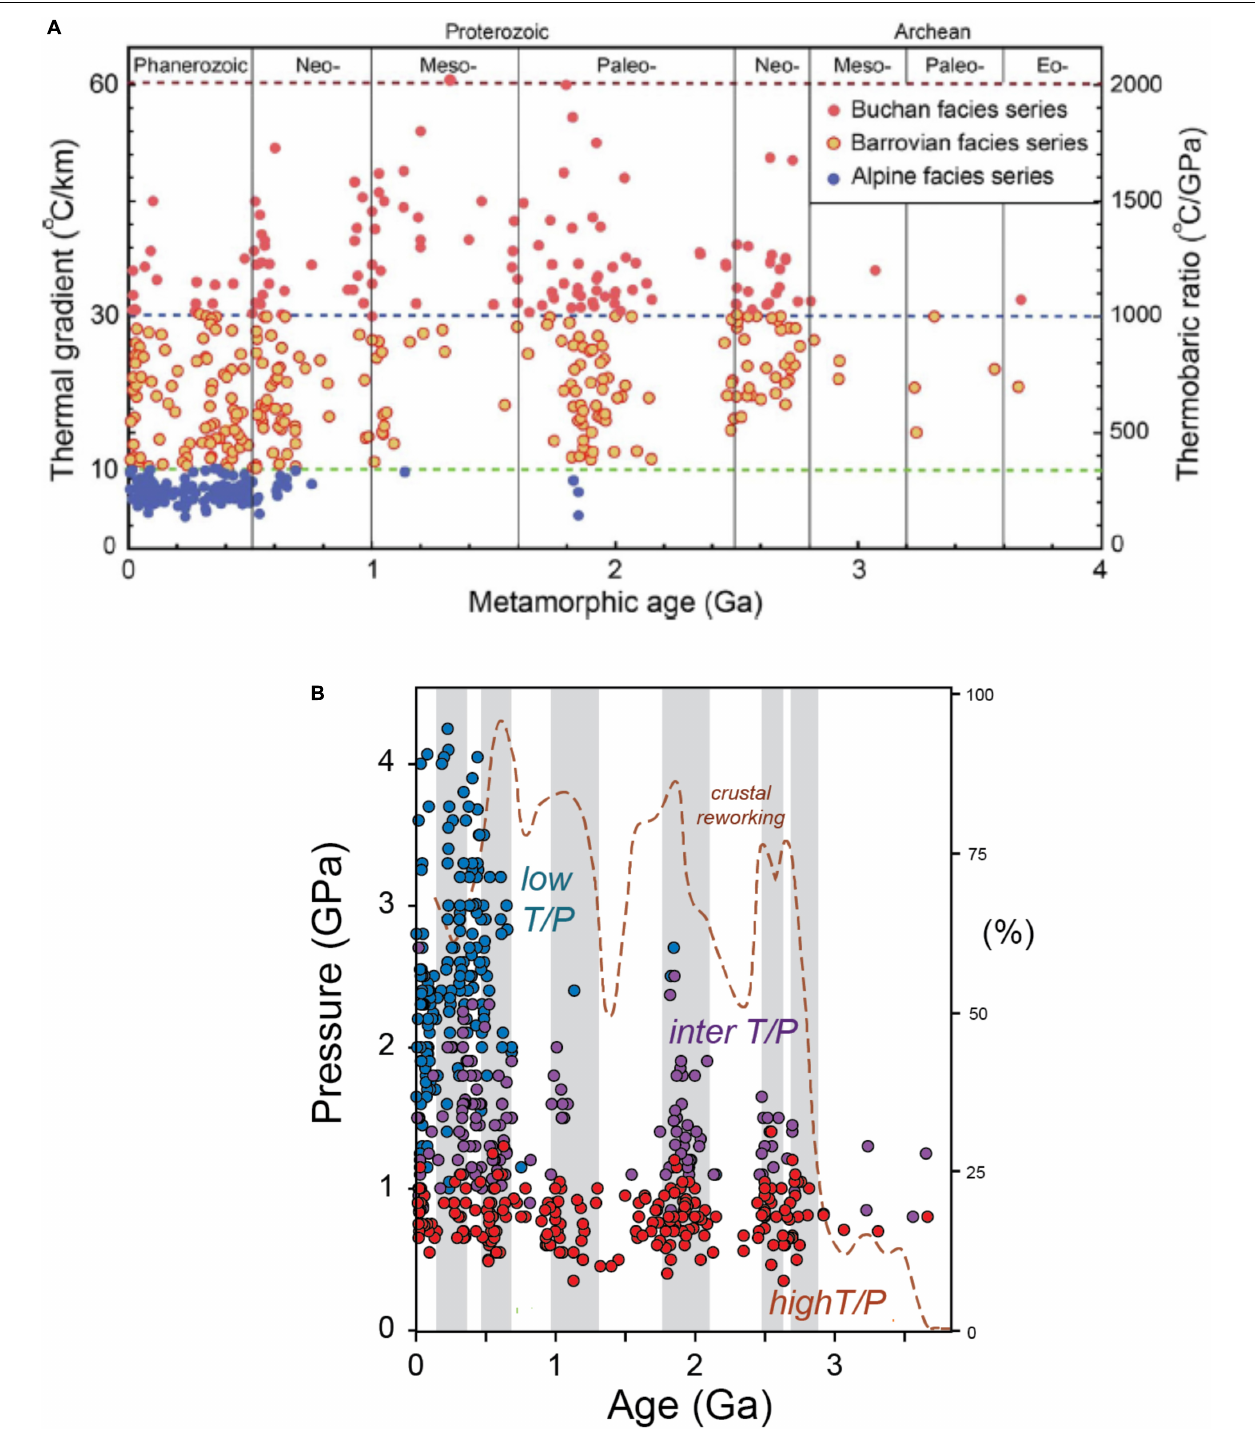
FIGURE 4 | Variations in metamorphic conditions with metamorphic ages (A) T/P values and bimodal associations through time from Zheng and Zhao (2020), (B) maximum pressure estimates in GPa through time, after Brown (2014), and from Brown and Johnson (2019). The crustal reworking curve is based on the Hf isotope ratios of zircons in different time slices (Dhuime et al., 2012), and the gray areas represent the ages of supercontinents plotted in Figure 1B after Campbell and Allen (2008).